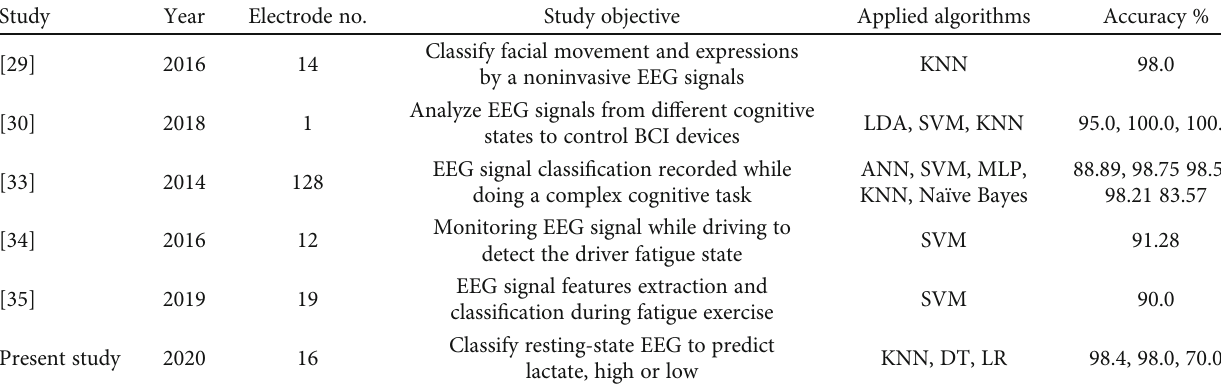
Table 4: Score results of various objective